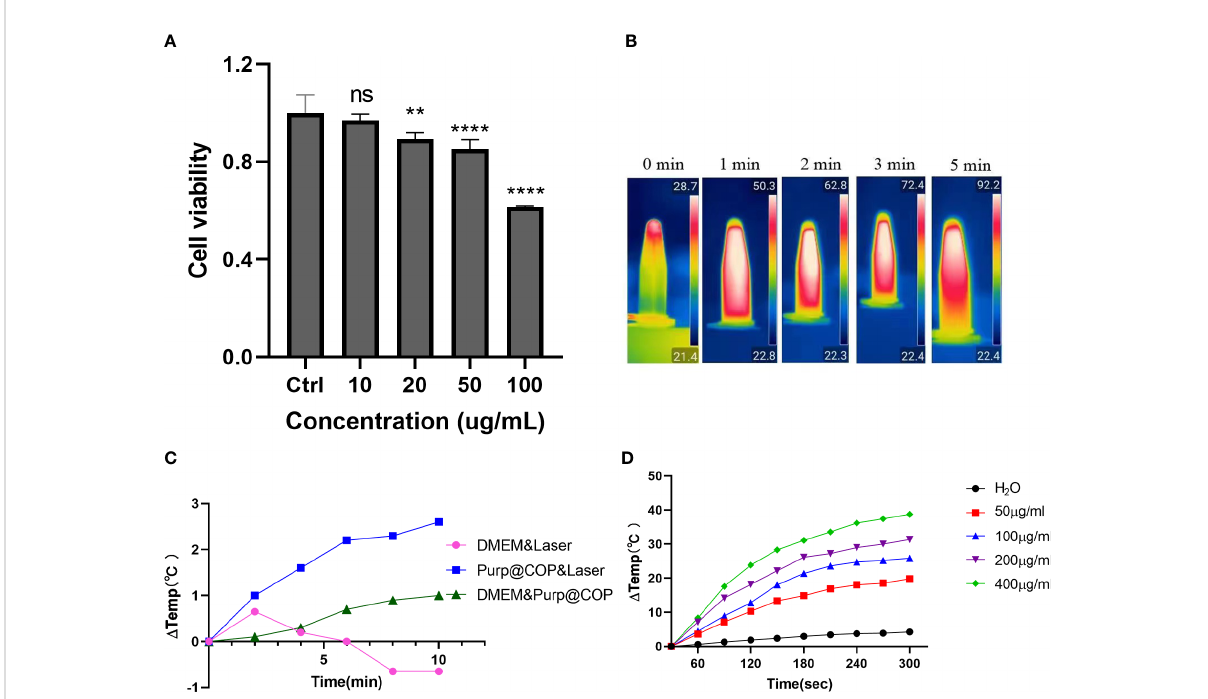
FIGURE 3 Heating effect results of Purp@COP. (A) Cell activity results of HepG2 cells after culture for 24 h with 10, 20, 50, and 100 m g/ml of Purp@COP. (B) Heating curve after irradiation with 1 W/cm 2 laser with or without 50 m g/ml of Purp@COP in a common culture dish. (C) Heating results of Purp@COP under laser (1 W/cm 2 ) irradiation. (D) The heating results of different concentrations of Purp@COP under laser (1 W/cm 2 ) irradiation. The symbols "**", "****" showed that the p value is less than 0.05,while "ns" showed